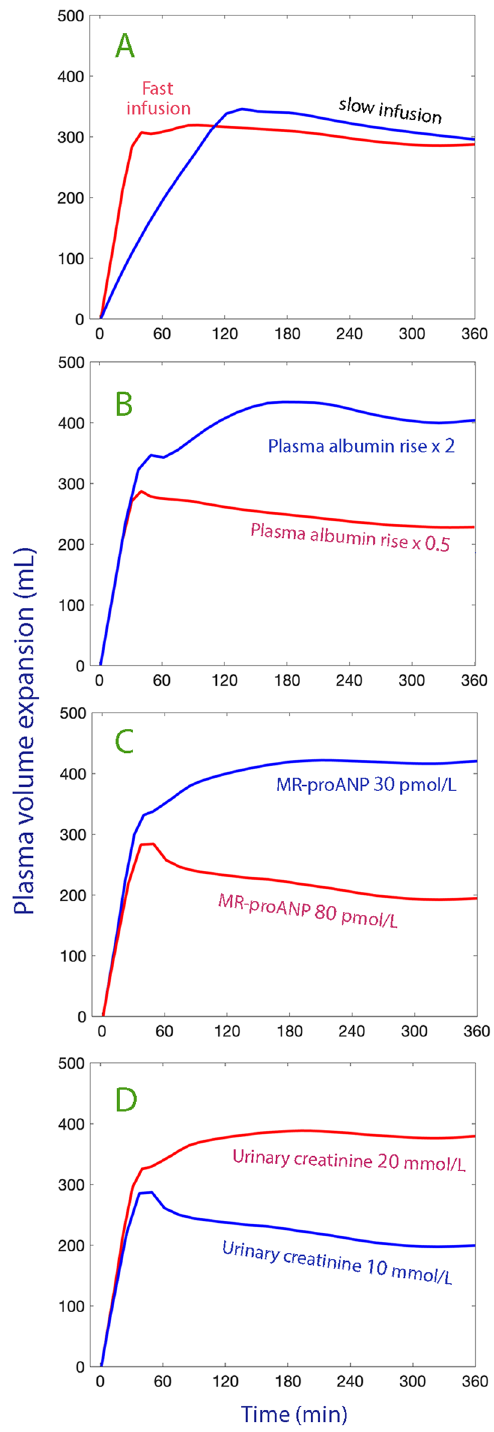
Fig. 6 Factors of importance to the plasma volume expansion. Computer simulations contrasting A rates of infusion B excessive ( 2) or reduced ( 0.5) increase in plasma albumin relative to the measured × × concentrations C the plasma MR-proANP concentration was high or low D whether the baseline urinary concentration of creatinine was high or low. The data from Table 2 were used. Simulations were performed by setting all kinetic parameters to the mean value except for the parameter that was varied. Subplots B – D were based on the kinetic data from all 24 experiments, but the plasma albumin measured during the 30-min infusion